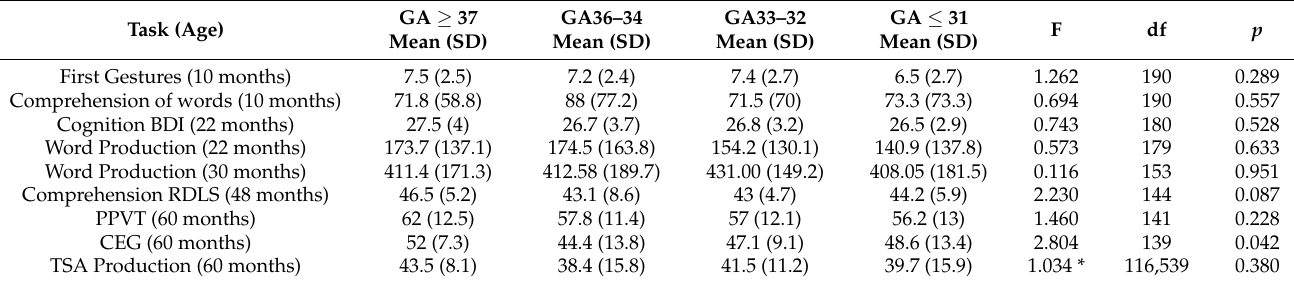
Table 3. Mean (SD) scores and ANOVA comparisons between the four gestational age (GA) groups. Task